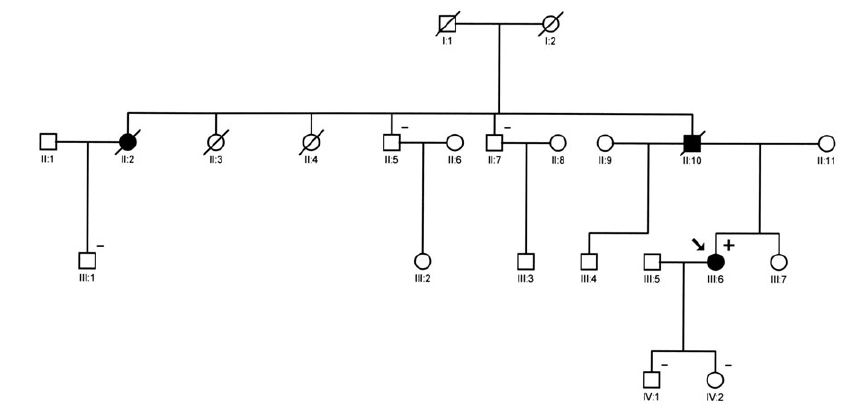
Figure 3. Pedigree of the family affected with the c.1442 dup A LMNA mutation. Circles represent women; squares men, black-filled symbols represent clinically affected; plus sign, presence of the c.1442 dup A LMNA mutation; minus sign, absence of the mutation.